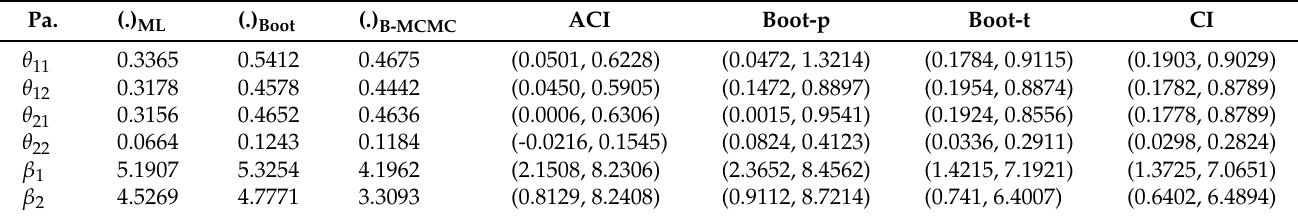
Table 7. Point estimates with 95% CIs of the parameters.